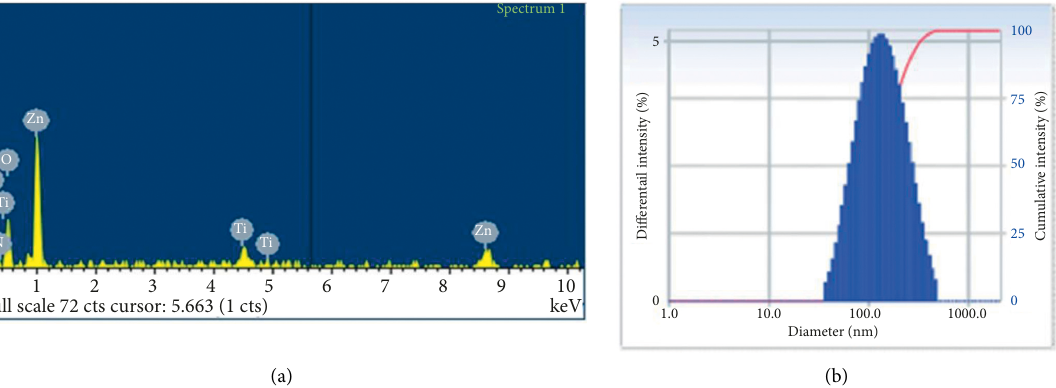
Figure 4: EDAX spectrum (a) and DLS spectrum (b) of ZnO-TiO